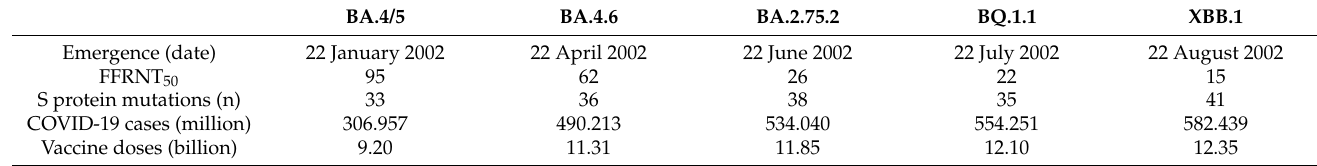
Table 1. Data of FFRNT 50 values for different SARS-CoV-2 Omicron sublineages in recipients of four doses of monovalent mRNA-based COVID-19 vaccines; date of emergence and number of spike protein mutations of the sublineages; cumulative worldwide COVID-19 cases; and cumulative number of COVID-19 vaccine doses administered worldwide at the time of the SARS-CoV-2 Omicron sublineage